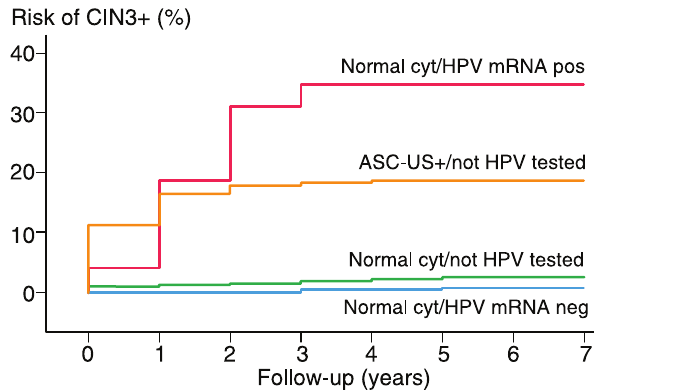
Fig 3. Cumulative incidence ratio of CIN3+ for 7 years follow-up. P < 0.001. CIN3+ = cervical intraepithelial neoplasia grade (CIN3), ACIS and cervical cancer. Normal cyt = Normal cytology = normal findings in screening of liquid-based cytology